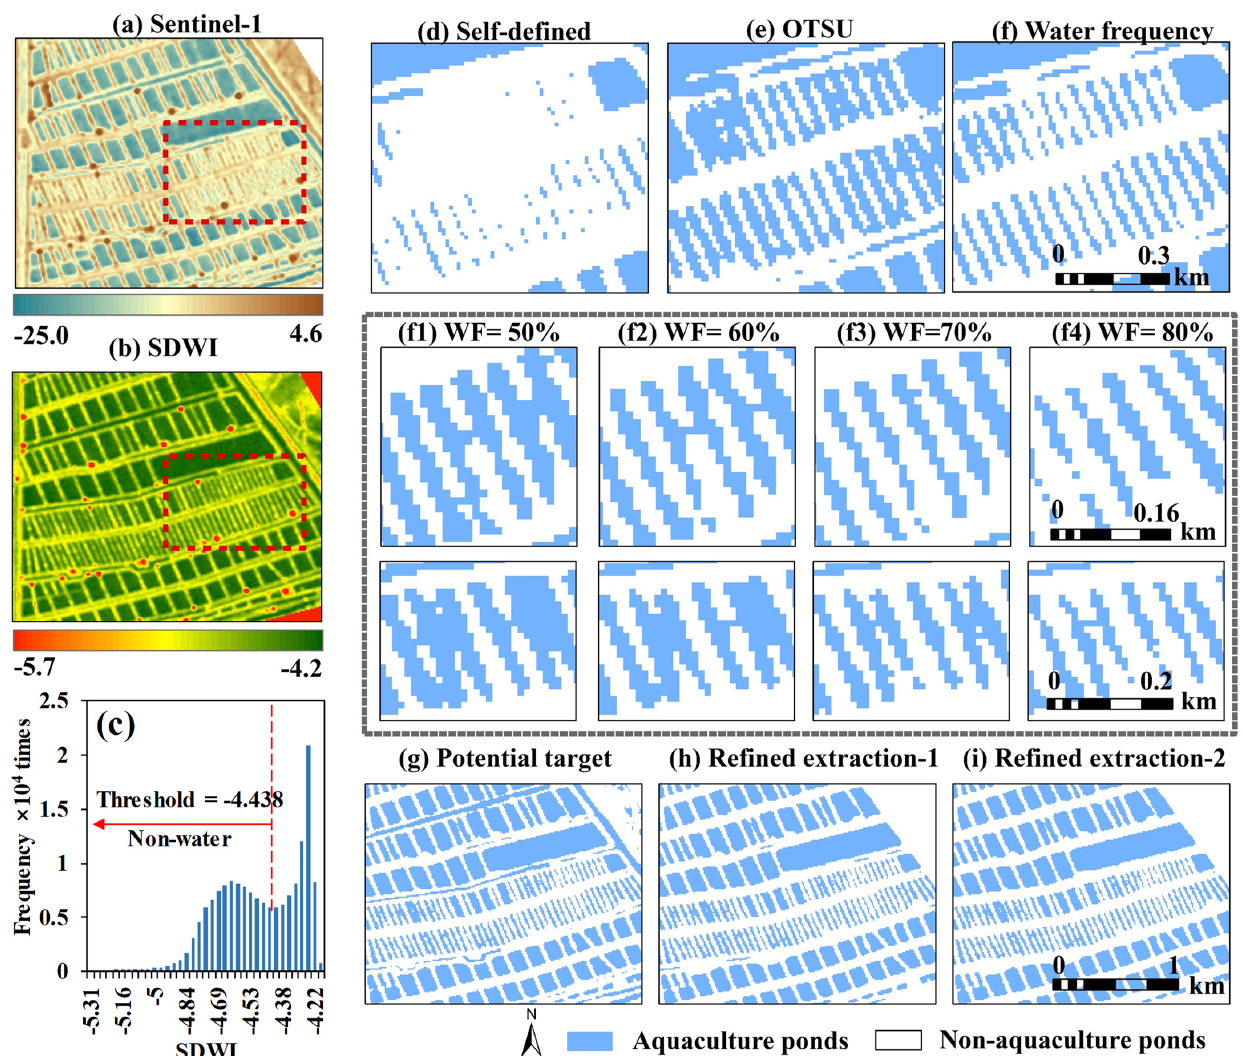
Figure 4. The workflow of aquaculture pond extraction. ( a ) Sentinel-1 original remote sensing image; ( b ) SDWI index; ( c ) frequency distribution of SDWI; ( d – f ) identification effect of potential aquaculture ponds after determining thresholds for self-defined, OTSU, and water frequency (WF) methods; ( f 1– f 4) potential aquaculture pond identification effects under different water frequencies; ( g )